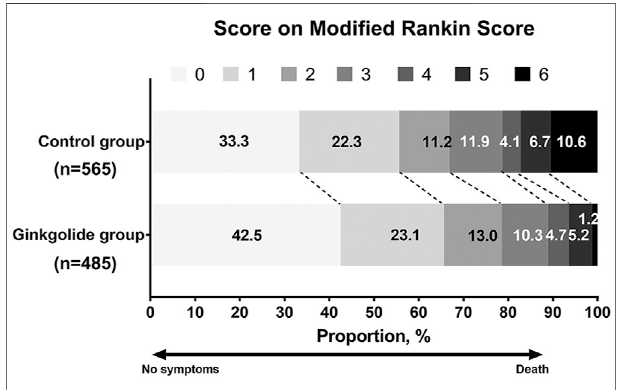
FIGURE 2 | Distribution of Modi fi ed Rankin Scores at 90 days Among Eligible Patients with Ginkgolide intervention vs. Control Group.